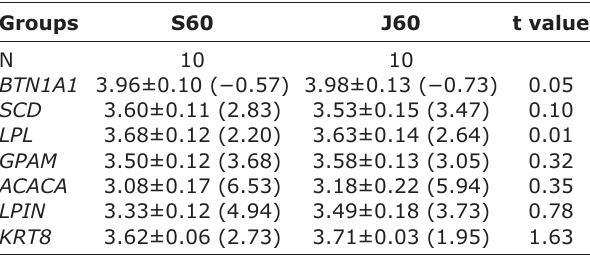
Table-4: Mean relative expression of major milk lipogenic genes and keratin gene between groups. Groups